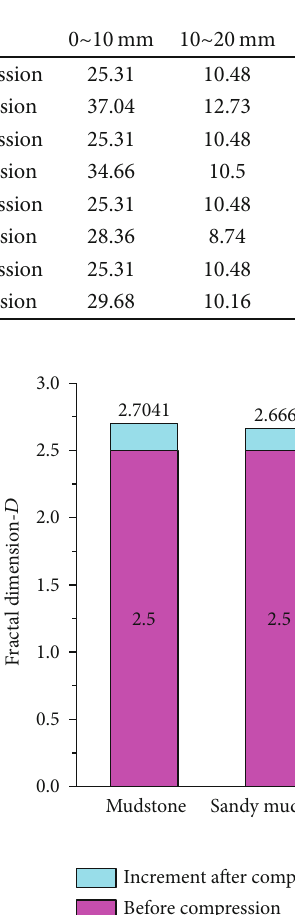
Figure 5: Variation of fractal dimensions of crushed rock samples of di ff erent lithology before and after compression (axial stress of